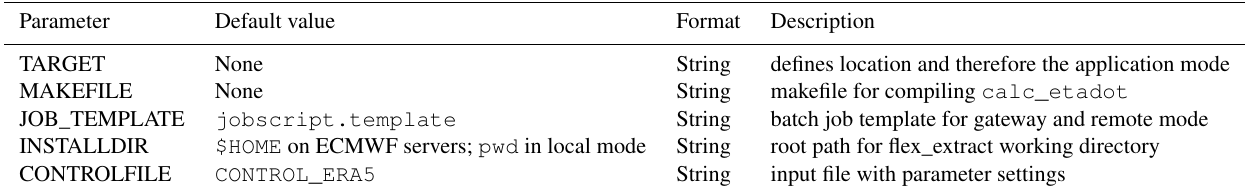
Table 11. Overview of parameters to be set in the setup.sh script for installation. In remote and local mode for member-state users, the file ECMWF_ENV will be created; hence the parameters from Table 9 must also be set in the setup.sh script.